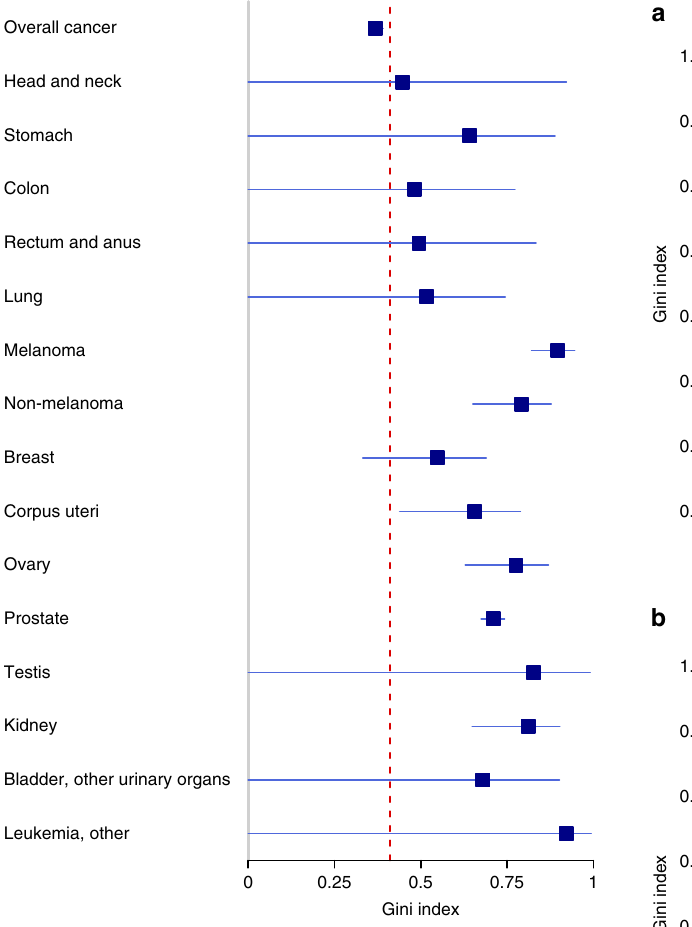
Fig. 2 Gini indices for 15 common cancers. The Gini indices with 95% con fi dence intervals are derived by using data from Nordic twin registries 20 . The red dashed line marks the Gini index of income in the USA